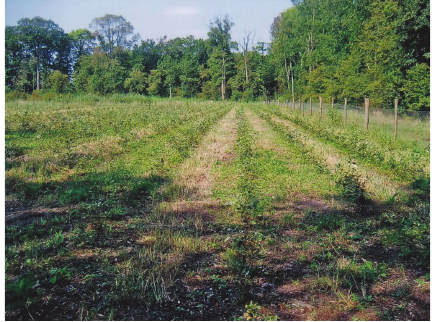
Figure 7: Water pools restored by means of channels.